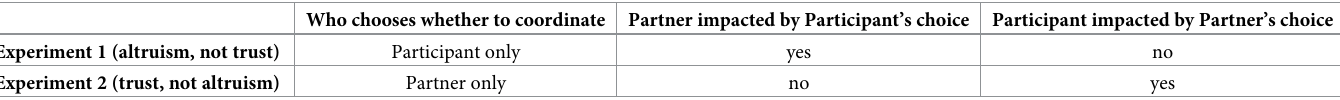
Table 2. Overview of differences in how participant and partner are impacted by each other’s choices in Experiments 1 and 2. Who chooses whether to coordinate Partner impacted by Participant’s choice Participant impacted by Partner’s choice Experiment 1 (altruism, not trust)